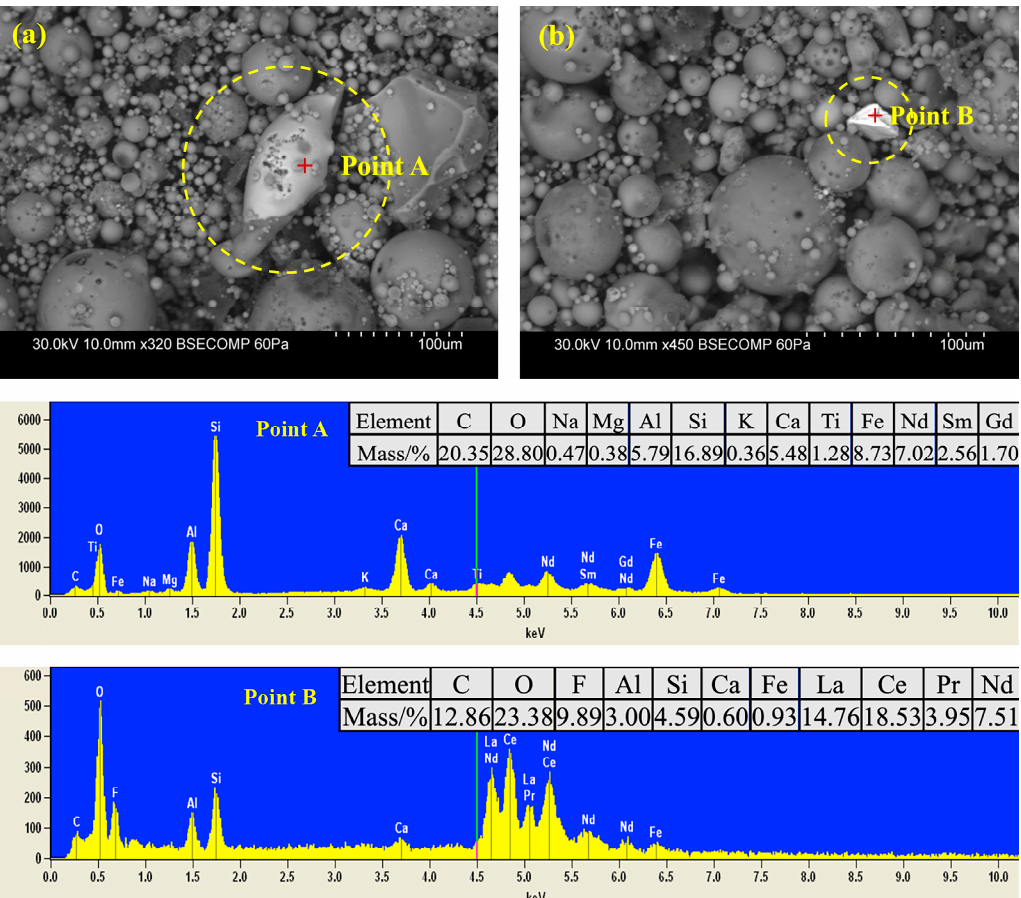
Figure 4. BSE image with element spectra of ( a ) an irregularly elongated-shaped amorphous carrier and ( b ) an irregularly shaped REE mineral—bastnasite.